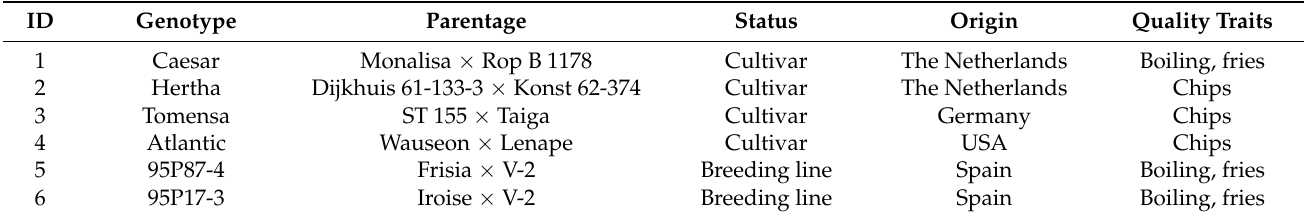
Table 1. Parents used in